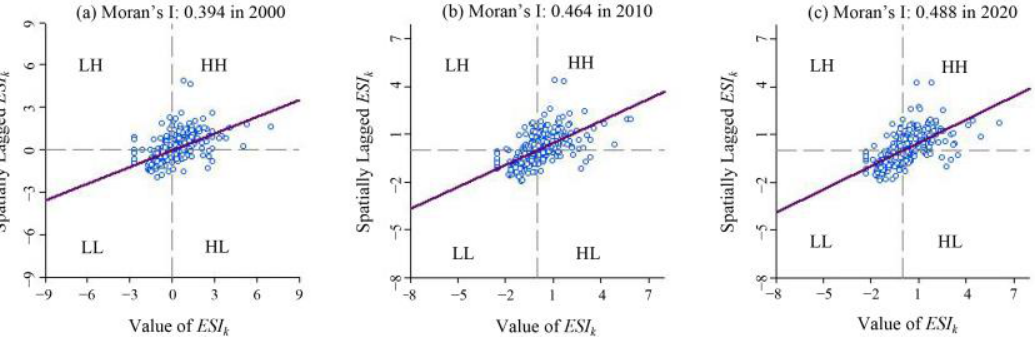
Figure 8. Scatter map of ecological security index of landscape pattern in the study area from 2000 to 2020.